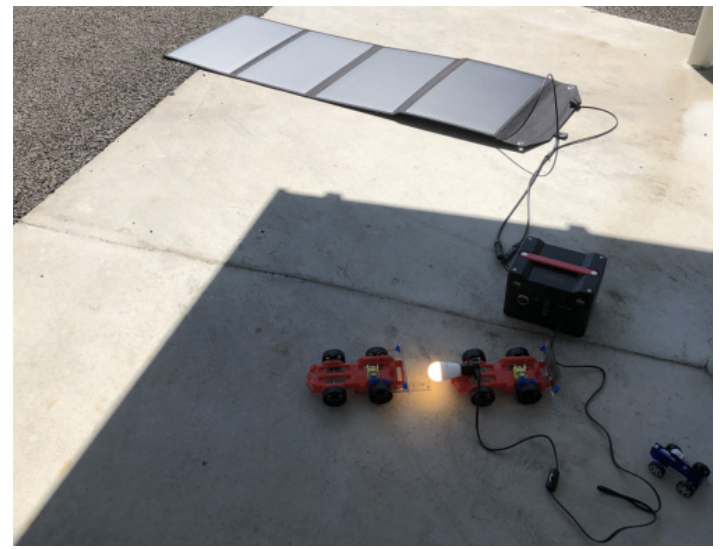
Figure 29. Experiment setup for dynamic optical wireless power transfer (WPT) between ground EVs using visible light [117].